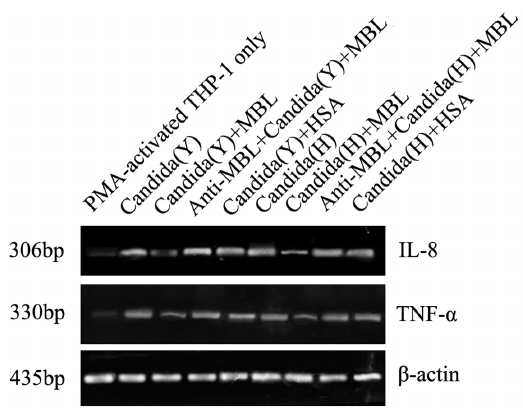
Figure 4. MBL inhibits C.albicans -induced IL-8 and TNF- a mRNA expressions in PMA-activated THP-1 cells. PMA-activated THP-1 cells were stimulated with HK Y or H cells of C. albicans at a Candida/ THP-1 ratio of 2:1 in the presence of the indicated concentrations of MBL, anti-MBL pAb and MBL, or HSA for 24 h. Samples were taken for RNA extraction from various groups, and the amplification and electrophoresis for IL-8, TNF- a genes were carried out at the same time. As an internal control, b -actin was used. These data are